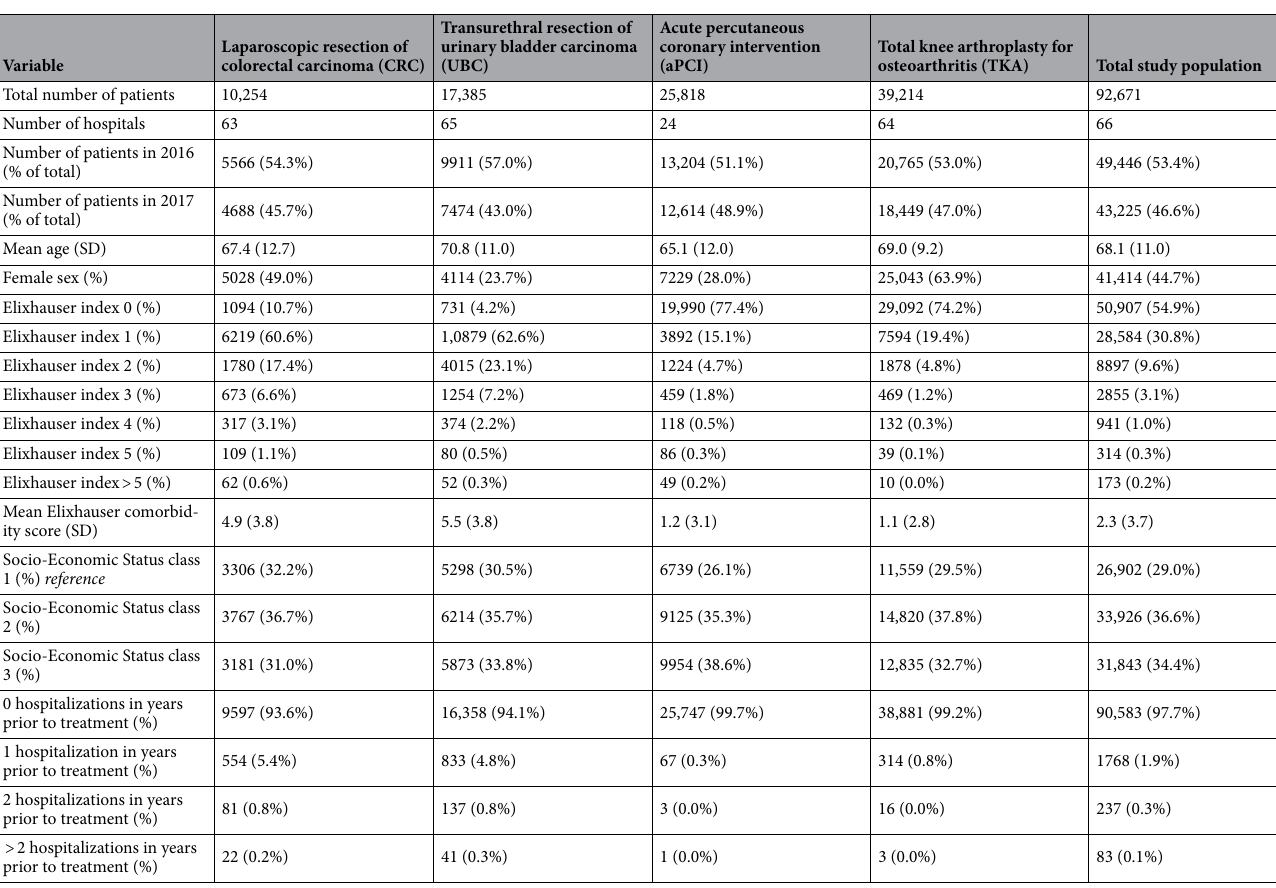
Table 1. Overview of study population and summary statistics of candidate PF variables, by surgical treatment.